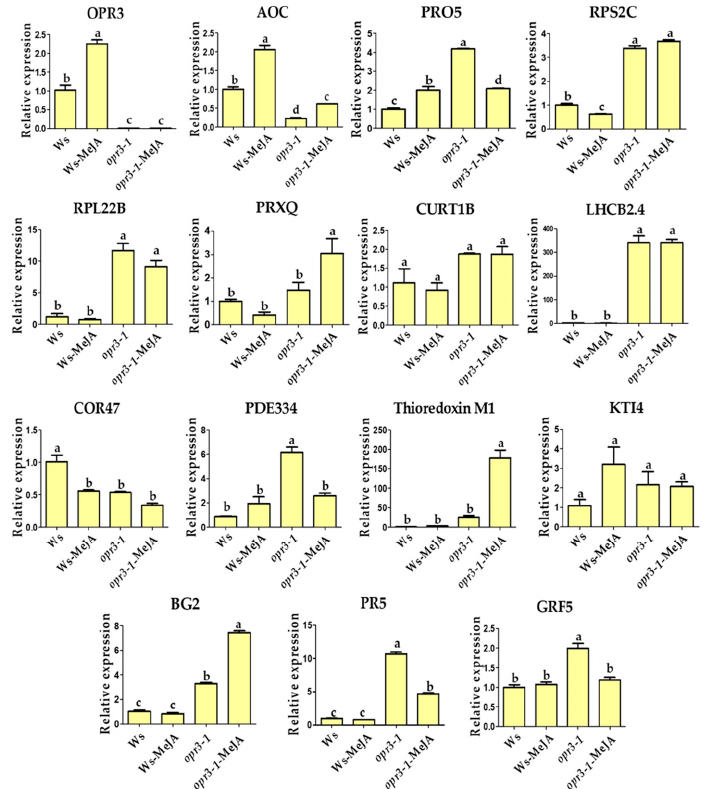
Figure 4. Relative mRNA expression levels of selected genes measured by qRT-PCR. OPR3: